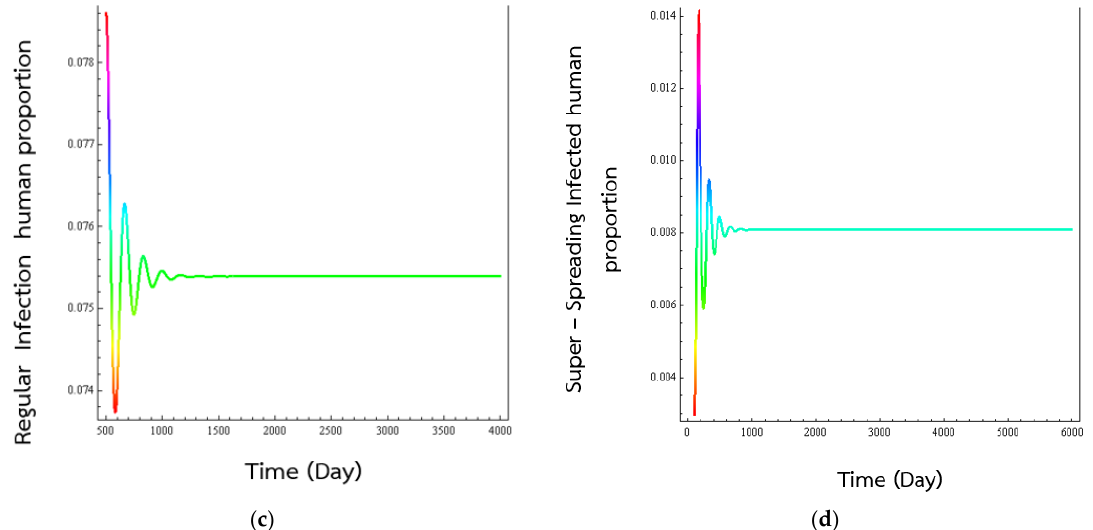
Figure 3. Numerical solution of systems (1)–(5), time series of ( a ) susceptible human population, ( b ) exposed human population, ( c ) regular infected humans, and ( d ) super-spreading infected humans to the transmission of respiratory disease. The numerical values of the parameters are values in the second column in Table 1. The values are representative values and have no medical significance and were picked in order for 1322.745 0 >= R . The percentage of exposed individual would became normal infected individual was set at p = 0.7. As is seen, the simulations have the solutions converging to the disease endemic state, which is true according to Theorem 3. The simulated human populations converge to the endemic equilibrium states ζ ∗ = ( S ∗ , E ∗ , I ∗ ) at (0.59161, 0.00145, 0.07539, 0.00807).